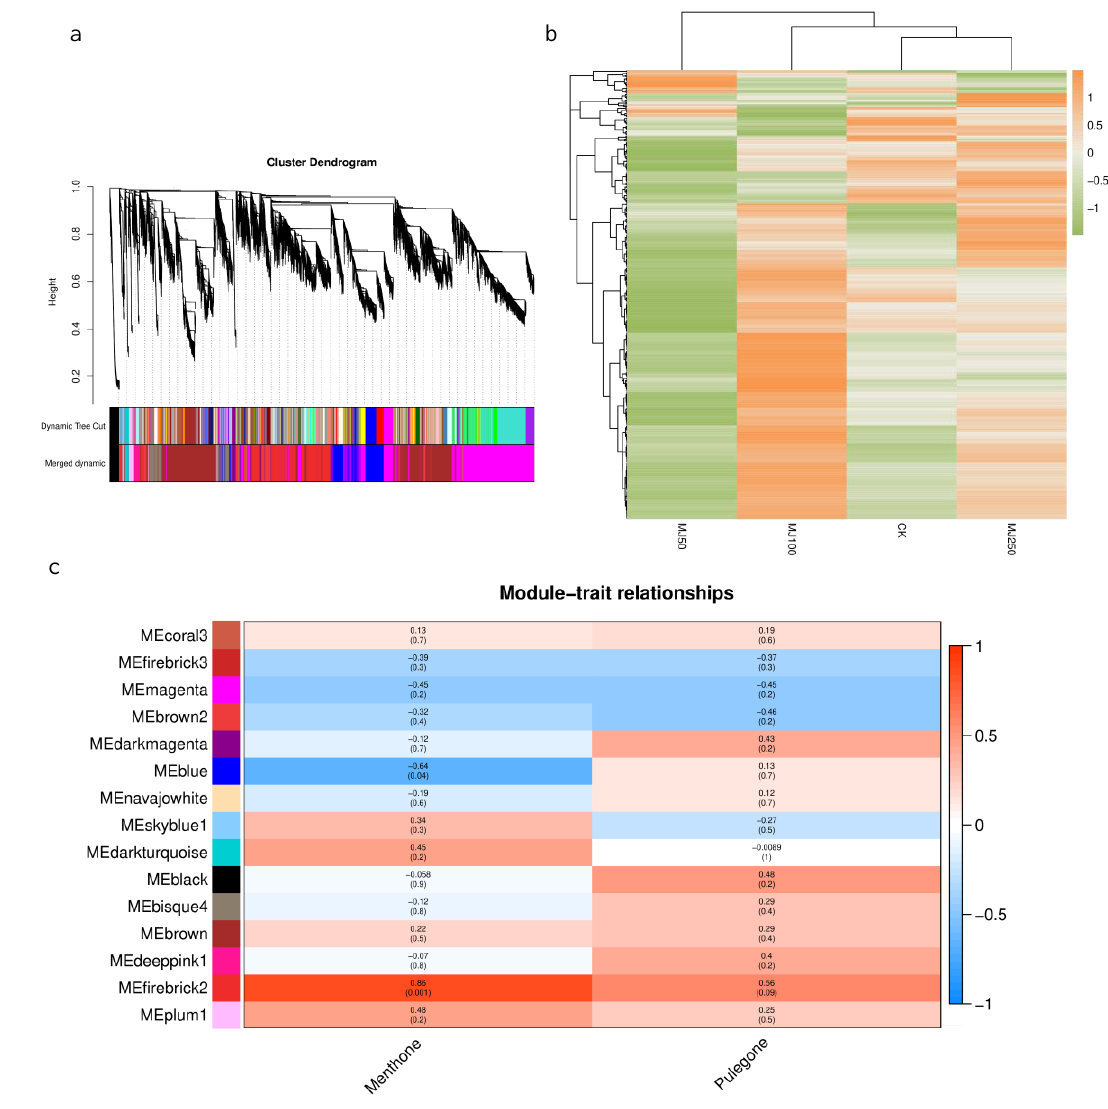
Figure 8. Weighted gene co-expression network analysis of the response of four MeJA − treated S. tenuifolia gene modules. ( a ) Gene hierarchy clustering dendrogram. Each color represents a module; ( b ) heat map analysis of ME firebrick 2 module gene clustering; ( c ) correlation analysis of gene modules with pulegone and menthone.